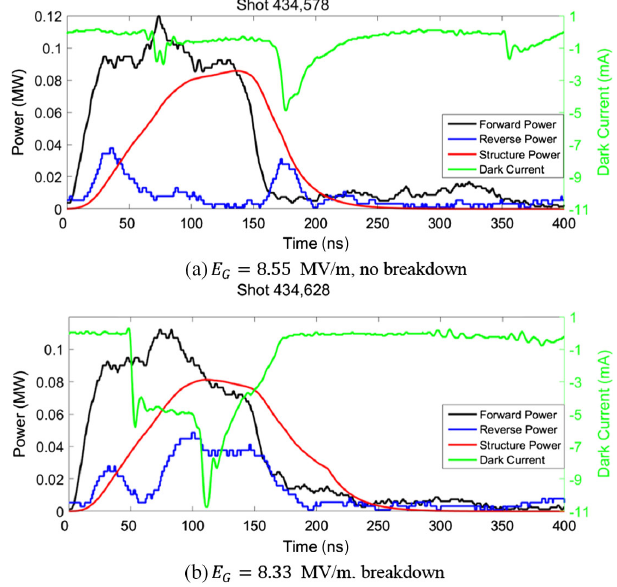
FIG. 22. Typical traces of the forward power, the reverse power, the calculated structure power and the dark current from the downstream Faraday cup for the HPBG-d3 structure with (a) no breakdown, and (b) breakdown showing the increased reverse power and dark current during